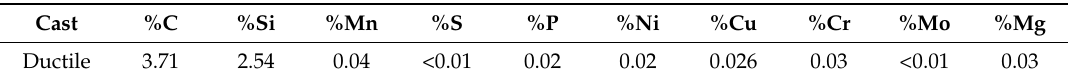
Table 1. Alloying elements of ductile cast iron.